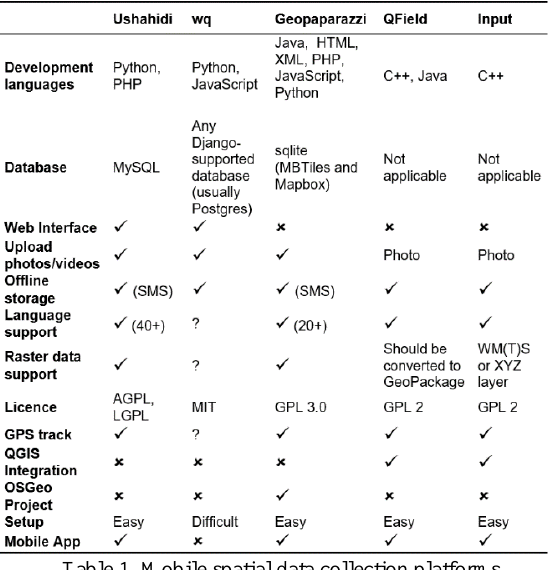
Table 1. Mobile spatial data collection platforms